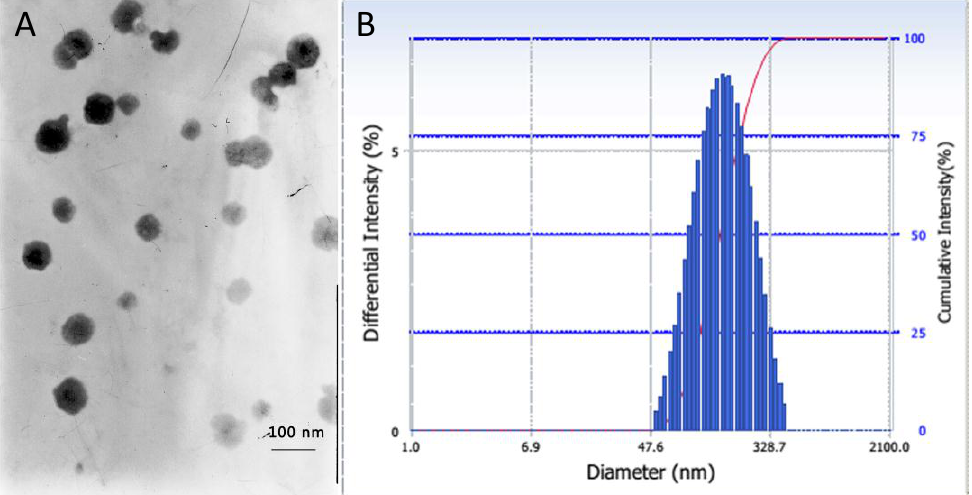
Figure 4. Characterization of P123–DTX conjugate micelles: ( A ) TEM image and ( B ) particle size by DLS.